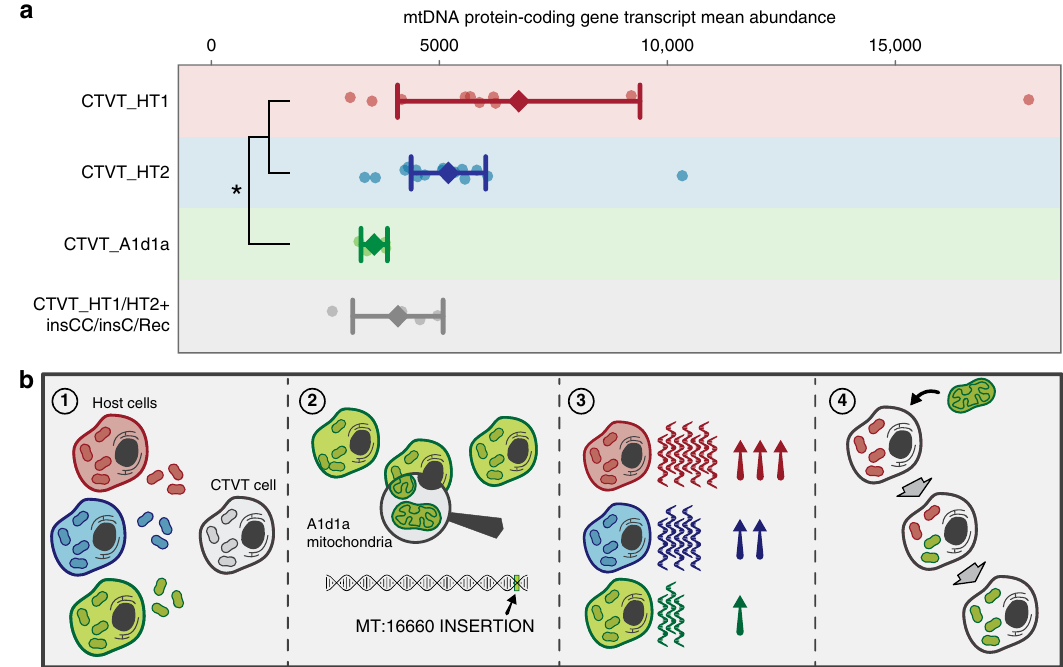
Fig. 3 MtDNA gene transcript abundance and model. a Mean abundance of mtDNA protein-coding gene RNA in CTVT_HT1, CTVT_HT2, CTVT_A1d1a and CTVT_HT1/HT2 + insCC/insC/Rec CTVTs ( n = 33). In the group of CTVT_HT1/HT2 + insCC/insC/Rec CTVTs (represented in grey), two carry 16660insCC and one carries 16660insC as a somatic mutation on CTVT_HT1 or CTVT_HT2 haplotype backgrounds, and one carries 16660insCC on a CTVT_HT1/A1d1a recombinant background. Dots represent mean abundances of mtDNA protein-coding gene transcripts in each of the CTVTs from each group, diamonds indicate mean mtDNA protein-coding gene abundances for each group and bars indicate 95% con fi dence intervals of the mean. Asterisk (*), p = 0.015 (two-sided Mann – Whitney test; Methods). Supplementary Data 6B provides batch-corrected transcript abundance data. b A model explaining repeated CTVT capture of the A1d1a haplotype. (1) All canine mtDNA haplotypes have equal opportunity for CTVT horizontal transfer, relative to population haplotype frequency. (2) A1d1a mtDNA haplotype carries an insertion in the control region, 16660insCC, which is not present in other haplotypes, and which may have regulatory functions. (3) MtDNA protein-coding transcript abundance is decreased in tumours with the A1d1a mtDNA haplotype relative to the two most common CTVT mtDNA haplotypes. (4) After A1d1a mtDNA horizontal transfer, A1d1a becomes homoplasmic through a sel fi sh replicative